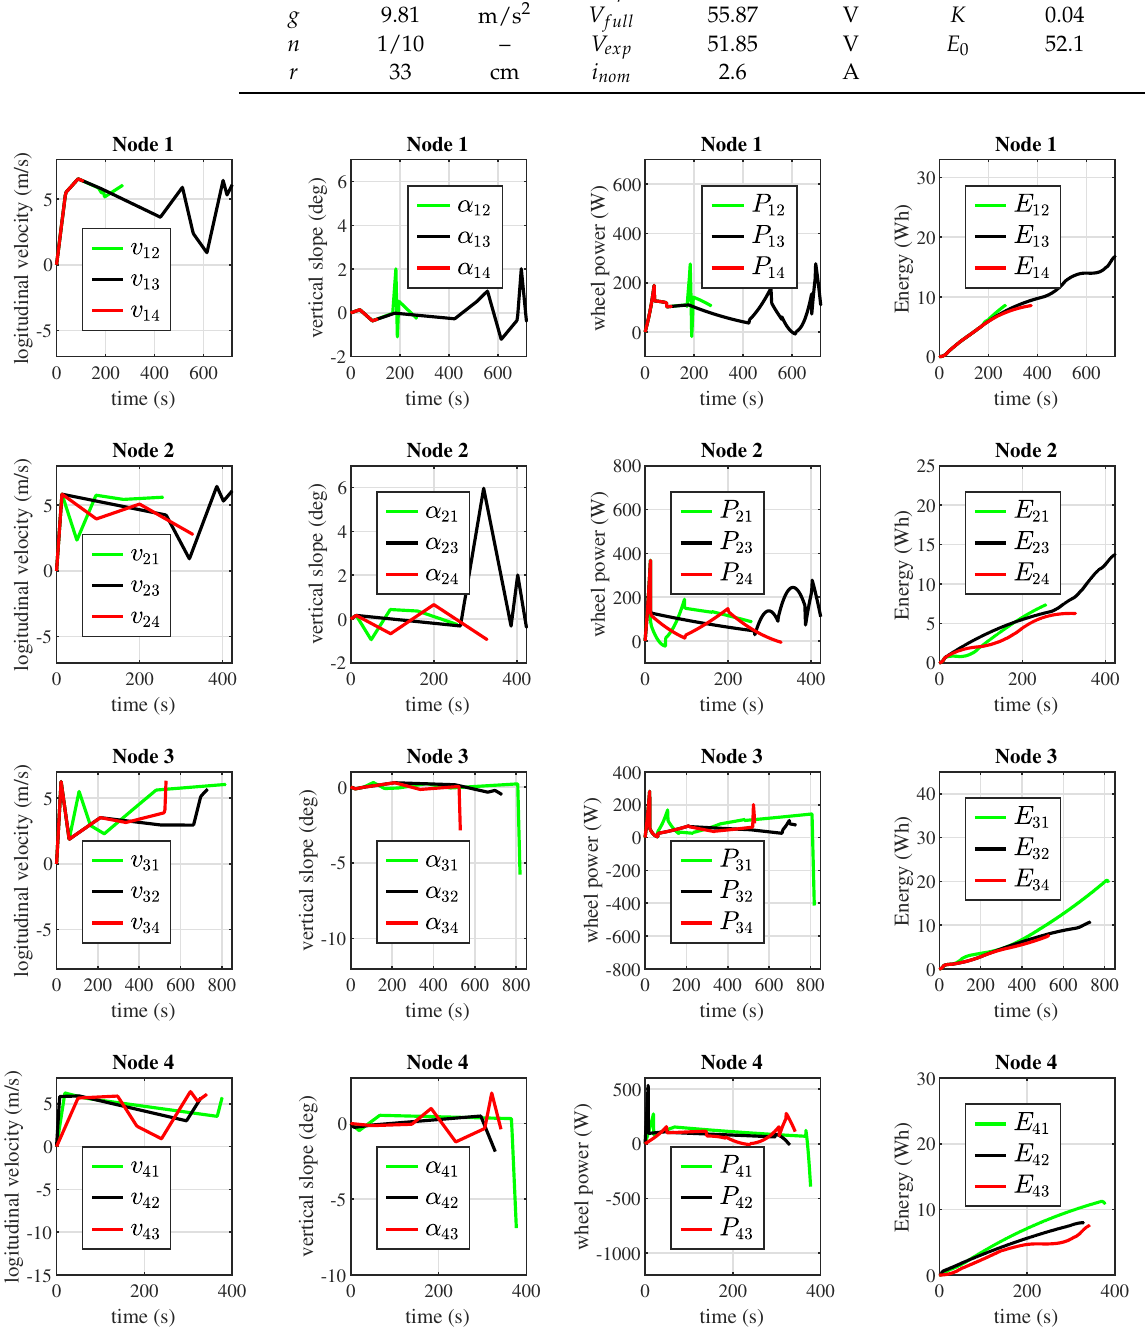
Figure 6. E-bike energy consumption estimation based on longitudinal velocity, road slope, and vehicle